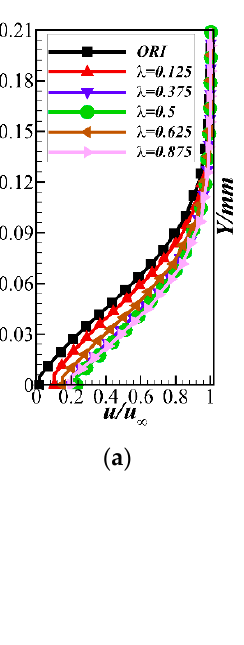
Figure 14. Vertical lines of suction surface at middle of blade.